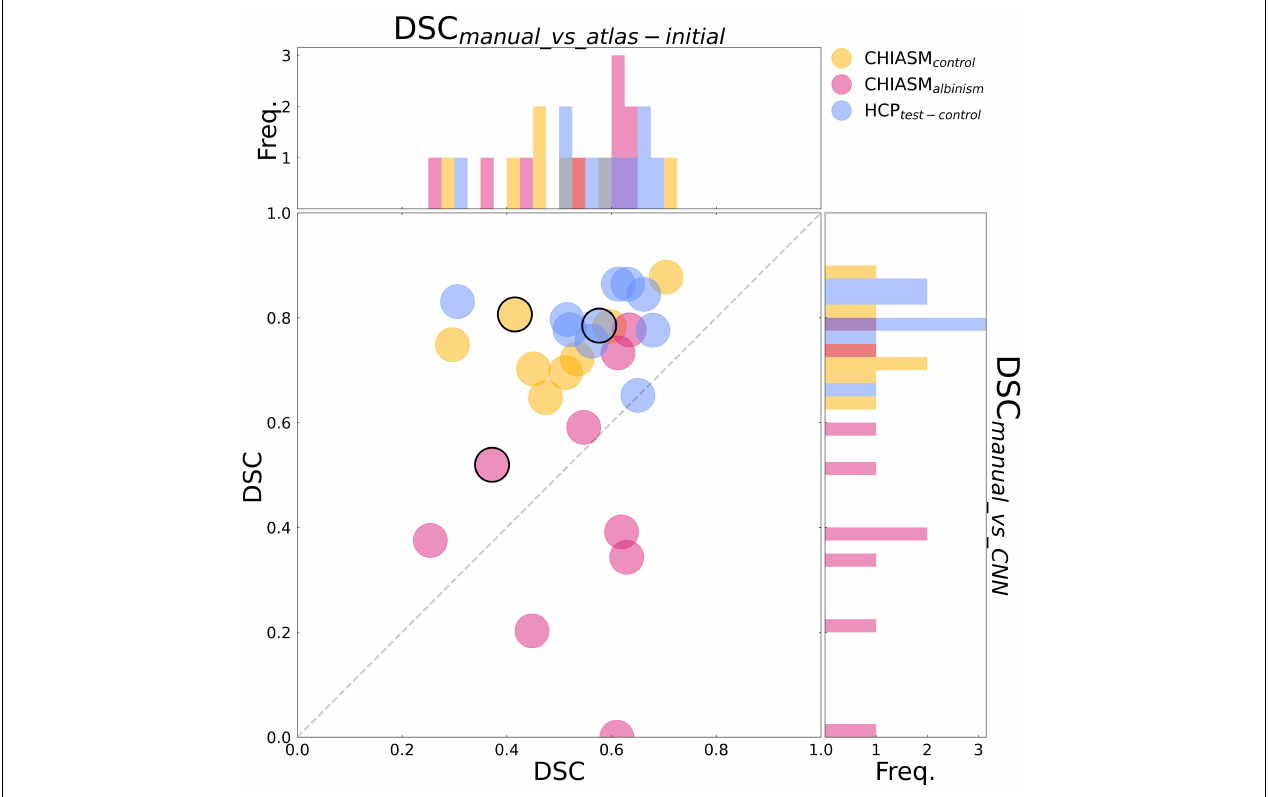
FIGURE 4 | Comparison of quality of X-mask atlas − initial and X-mask CNN . Scatter plot of DSC manual_vs_atlas − initial (x-axis) and DSC manual_vs_CNN (y-axis) values for CHIASM albinism ( n = 9), CHIASM controls ( n = 8), and HCP test-controls ( n = 10). The values are additionally presented in the form of marginal histograms of the two distributions—DSC manual_vs_atlas − initial (top horizontal) and DSC manual_vs_CNN (right vertical). The black contours mark the data point of the representative participants, depicted in Figure 5 . The outlier data point indicating DSC manual_vs_CNN = 0 corresponds to a single case, where the chiasm could not be correctly identified. Specifically, X-mask CNN was defined as a largest cluster of voxels with positive predictions (as output by CNN). In this unique case, however, the largest cluster was located outside the chiasm, in the